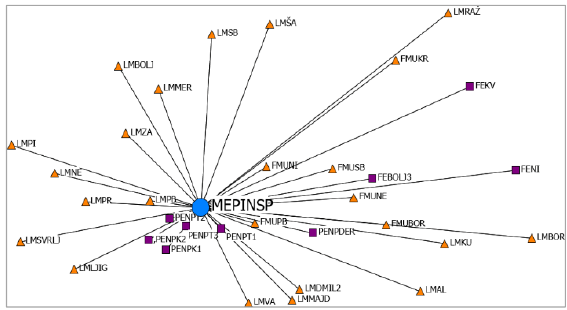
Figure 4. The networks per area for the collaboration climate change governance in forestry and nature conservation: ( a ) Remediation of forest damages from ice breaks, floods, and fires (Area 1); ( b ) Workshops, seminars and expert knowledge exchange (Area 2); ( c ) Tree planting, waste disposal and green space maintenance (Area 3); ( d ) Project related activities (Area 4); ( e ) Climate-related data and information exchange (Area 5); ( f ) Information exchange with emergency departments and divisions (Area 6); ( g ) Information exchange concerning environmental monitoring and precaution (Area